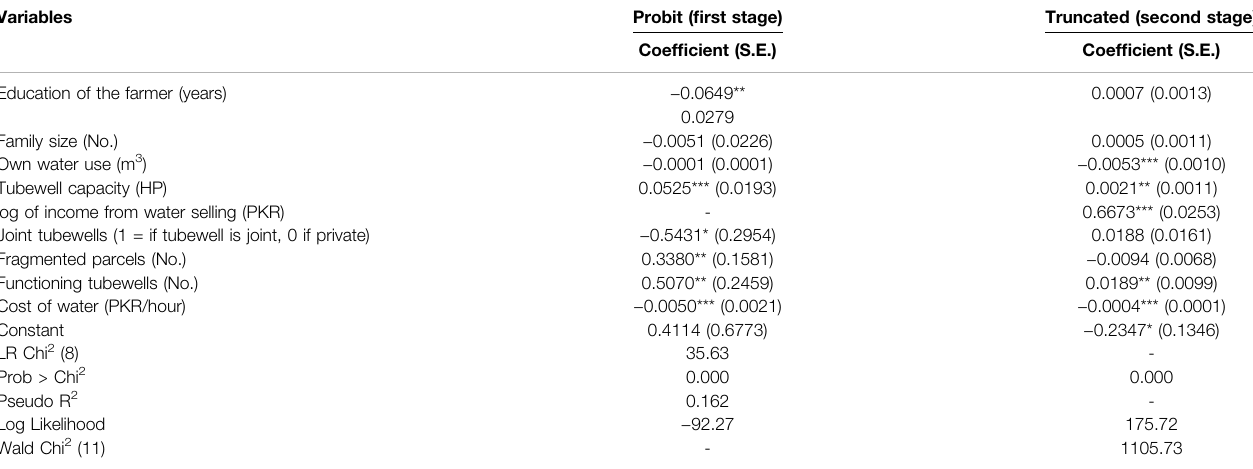
TABLE 5 | Factors affecting water selling and level of water selling.